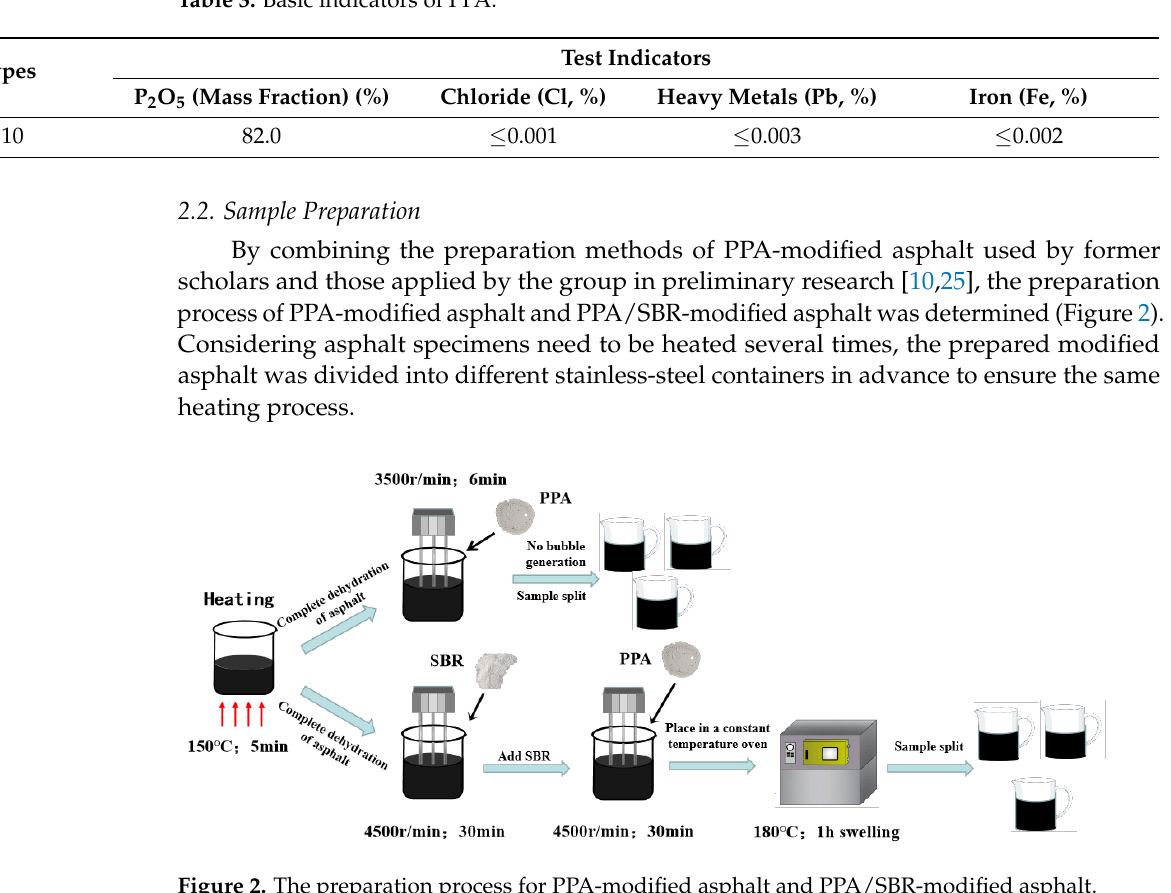
Table 3. Basic indicators of PPA.